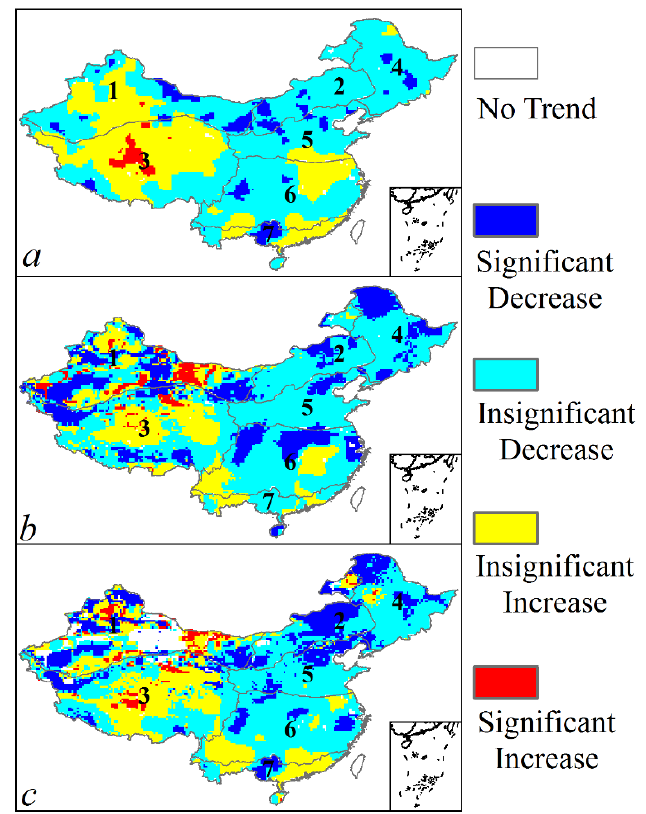
Figure 8. Spatial distributions of the trends in 12-month SPI, SSI, and SRI over 1948–2010 in China. ( a ) SPI, ( b ) SSI, and ( c ) SRI. Significant (insignificant)—passing (not passing) the signified test at the confidence level of 95% using the modified Mann-Kendall (MMK) test.